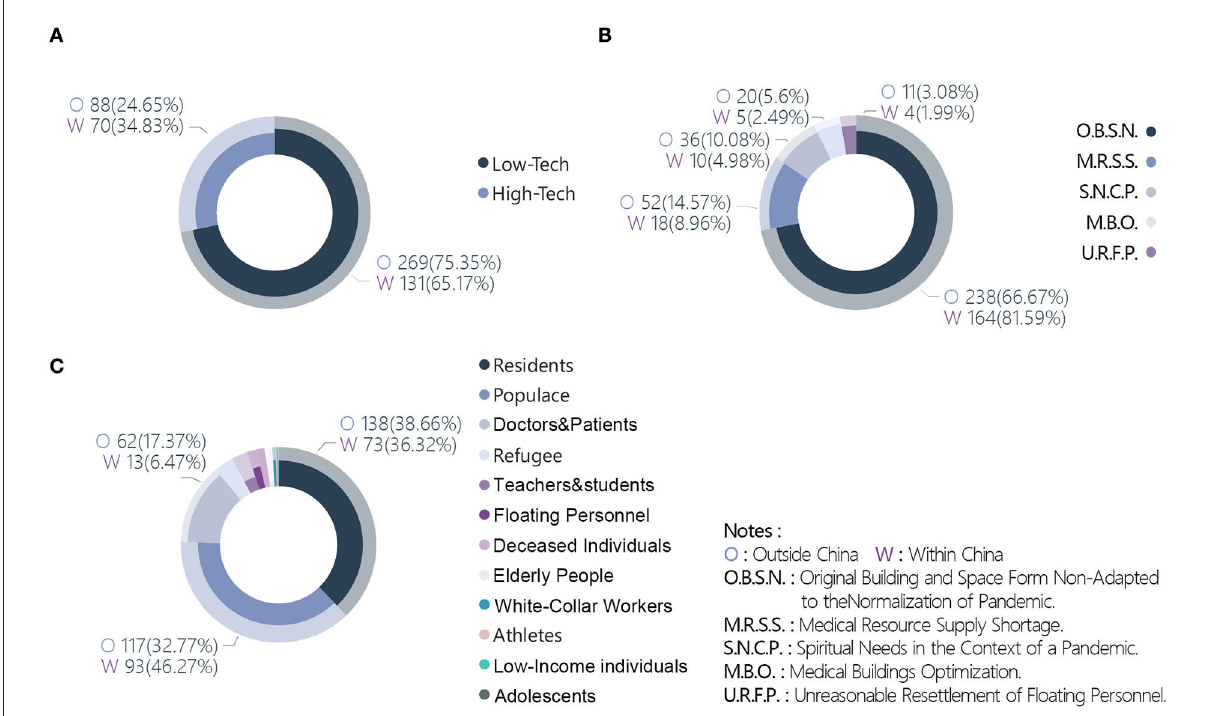
FIGURE8 Cross-tabulation results with territory. (A) Territory and technical orientation. (B) Territory and target problem. (C) Territory and target group.